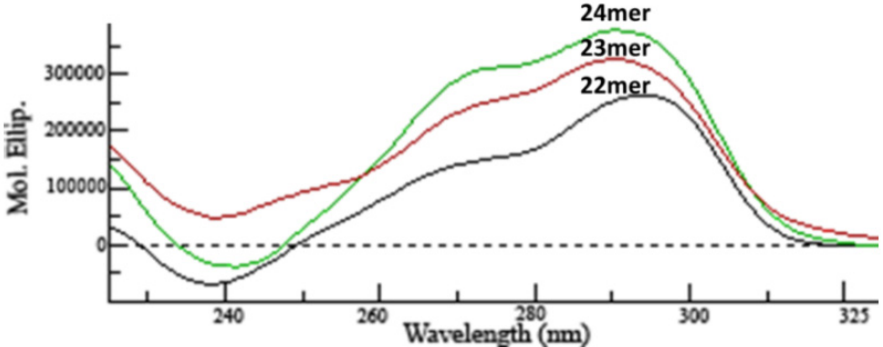
Figure 1. CD analysis was performed on a JASCO J-815 spectrometer at 5 μ M strand concentrations in BPE-P. The parent h-Tel22 sequence (black) is 5'-AGGG(TTAGGG) Addition of 5'-T forms the 23-mer (red) and addition of 5'-TT forms the 24-mer (green). Spectra were obtained at 25